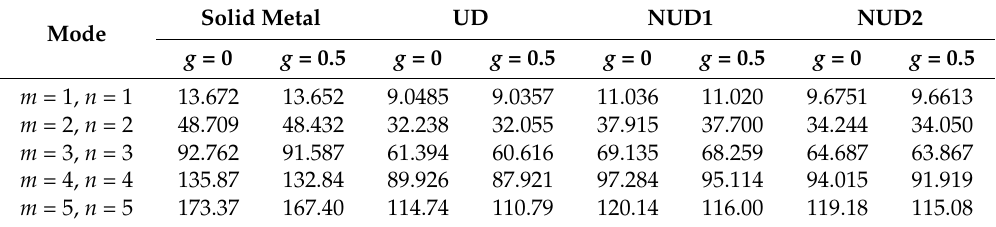
Table 2. The non-dimensional buckling loads with different mode numbers, small scale parameters and porosity distributions of rectangular FG nanoporous nanoplate ( l a = 50 nm, l b = 75 nm, h = 5 nm, ζ = 1, λ = 0.5).